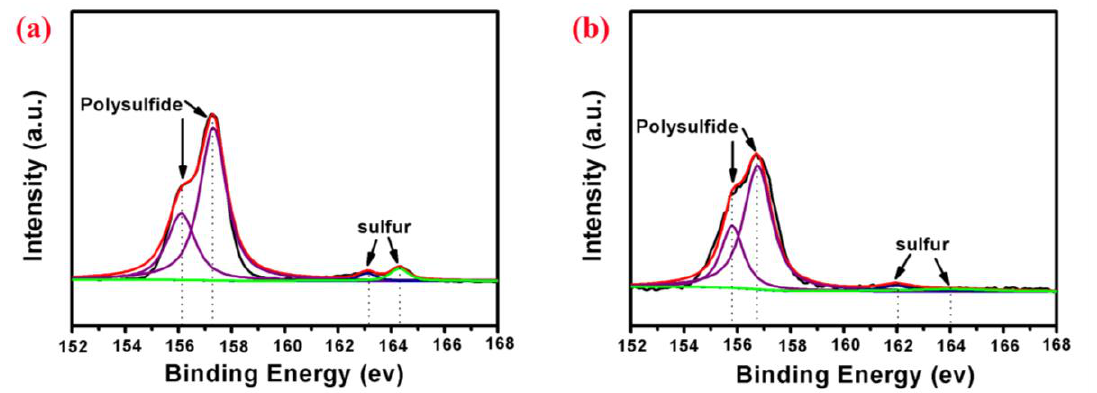
Figure 8. S 2p XPS spectra of the ( a ) S/CeO 2 /RGO and ( b ) S/RGO cathodes after 200 cycles.